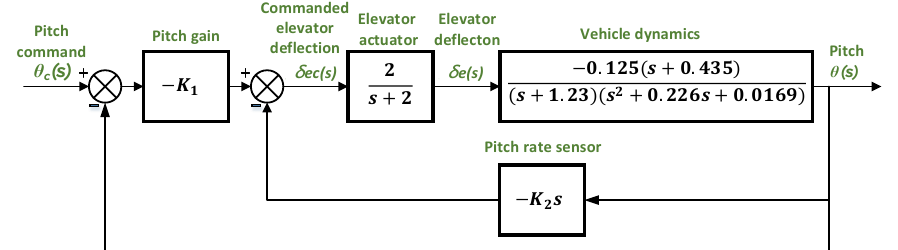
Figure 3. Closed-loop representation of the pitch control